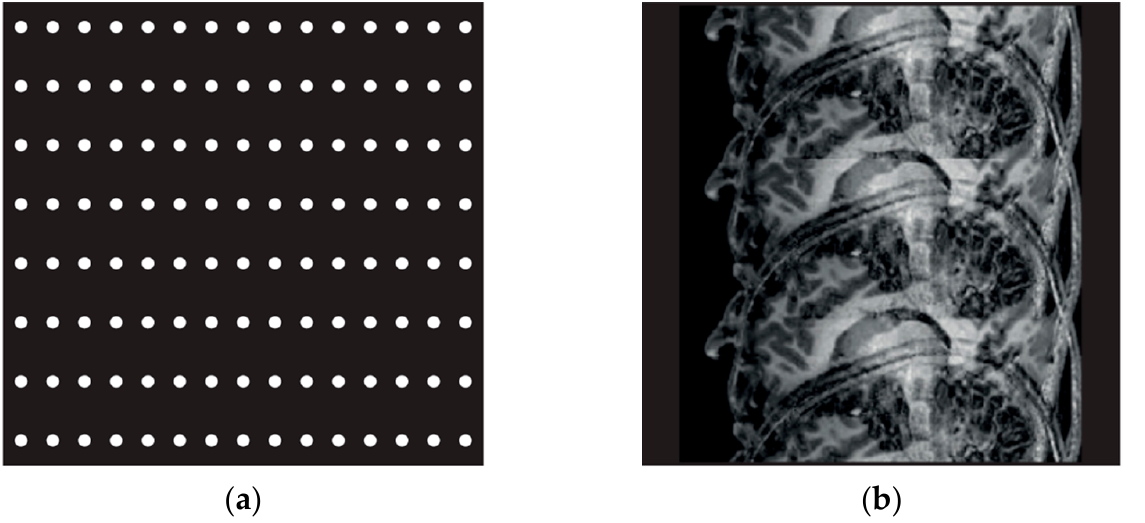
Figure 1. SENSE Techniques. Parallel Imaging ( a ), Aliasing Artifact ( b ).